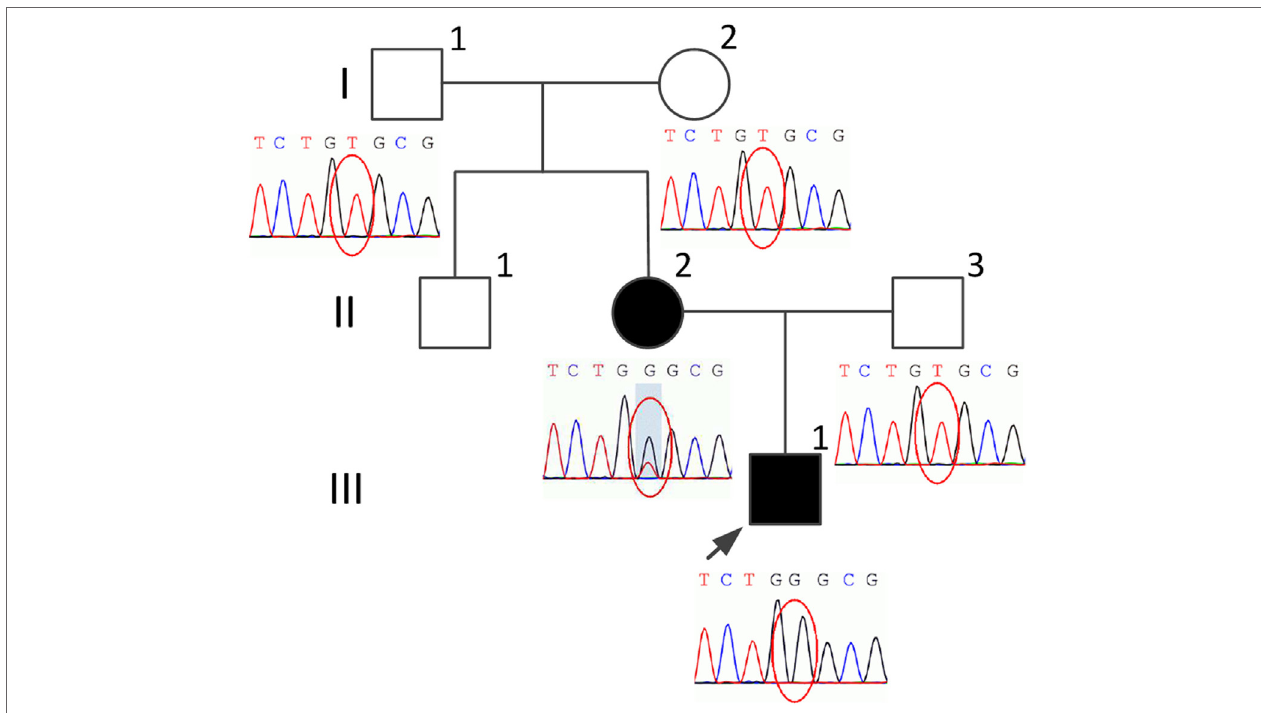
FIGURe 1 | Pedigree of the present family and the variant screening diagrams. The proband is indicated by an arrow. Black indicates affected. Squares indicate males. Circles indicate females.